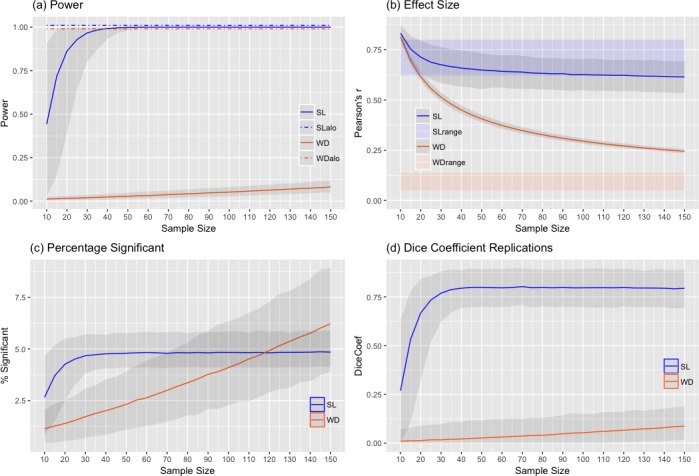
Results of the sampling simulations.Relation between sample size (n) and (a)
average (solid line) and at least one (alo; dashed line) statistical power; (b) detected effect size (Pearson’s r) in the samples, and the full population effect size range (shown as a colored transparent bar); (c) Percentage of voxels below the threshold (p < .01); (d) mean dice coefficient: spatial overlap of significant (p < .01) voxels between two subsequent replications. SL; Strong Localized effects, WD; Weak Diffuse effects. The shaded grey area around the estimates reflects the 95% confidence intervals based on the sampling distribution.